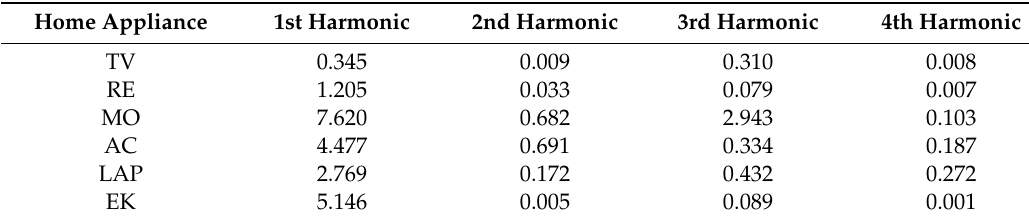
Table 3. 1st to 4th harmonic of six home